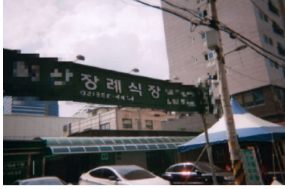
Figure 4. Funeral